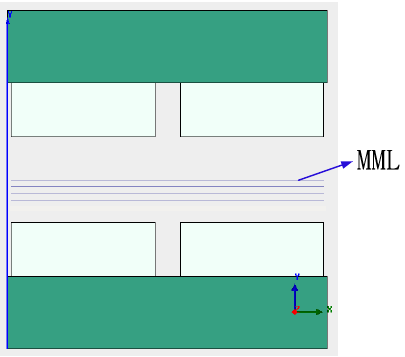
Figure 12. Illustration of the group of lines in the air-gap.